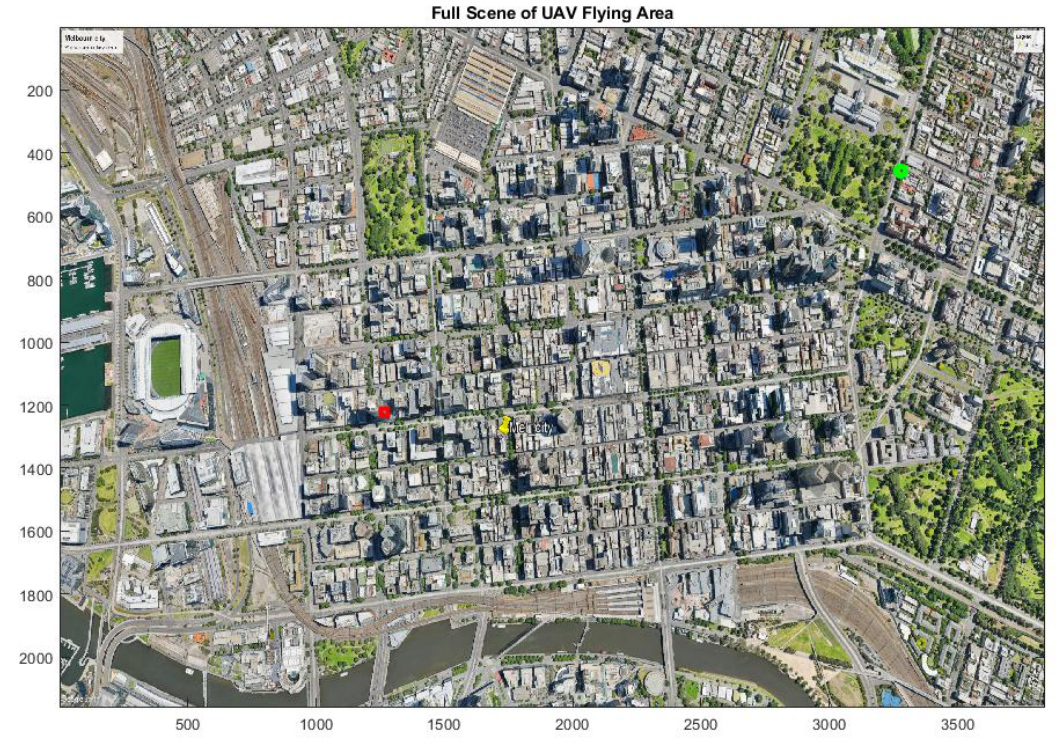
Figure 7. Entire UAV flying zone for simulation generated using Google Earth Pro. The red square is the UAV takeoff location and the green circle is the location where the reference image is